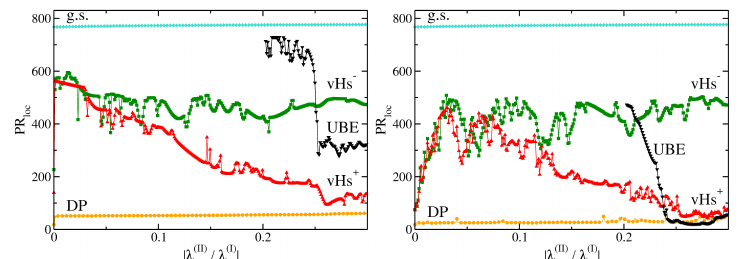
Figure 13. Evolution of the participation ratio PR loc ( E ) for the ground state (g.s.) and the most localized states at the van Hove singularities vHs − (squares) and vHs + (triangles up), the DP (disks) and at the peak emerging in the DOS at the upper band edge (UBE) for λ (cid:38) 0.20 (triangles down) in the hexagonal lattice with 1656 sites (24 rows of 34 and 35 sites, respectively) as a function of λ ( II ) / λ ( I ) with λ ( III ) = − λ ( II ) /2. The case of no noise ( left ), corresponding to situations shown in Figure 3, is compared to weak noise affecting λ ( I ) , λ ( II ) and λ ( III ) , with relative strength | δ Localization is enhanced when introducing noise up to about | λ ( II ) / λ ( I ) | (cid:46) 0.03, where the value of PR loc ( E ) saturates for the vHs − at the same values as in the noiseless case, whereas it starts to decrease again at the vHs + and saturates when the third peak appears in the DOS.